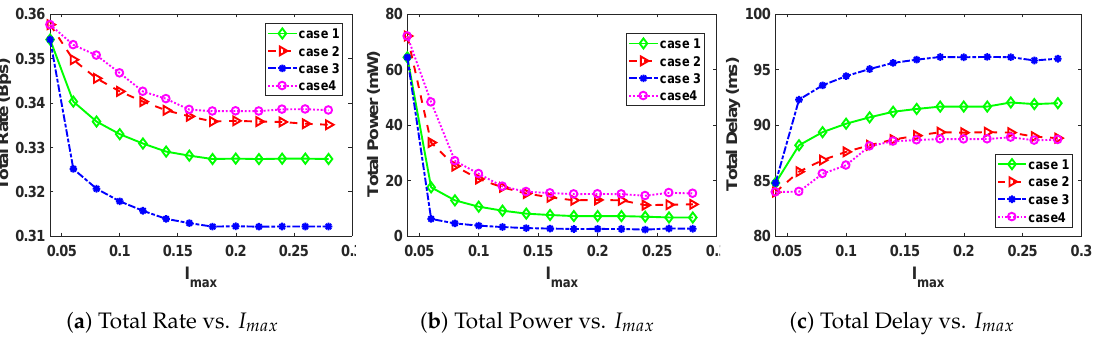
Figure 1. Effect of changing maximum interference I max , on the optimal rate, power and